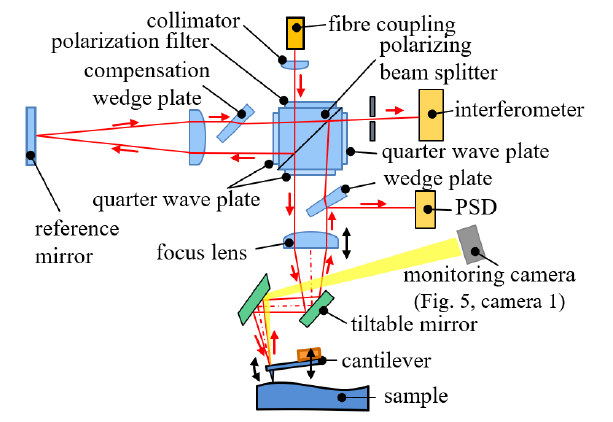
Figure 1. Functional principle of the MAFM